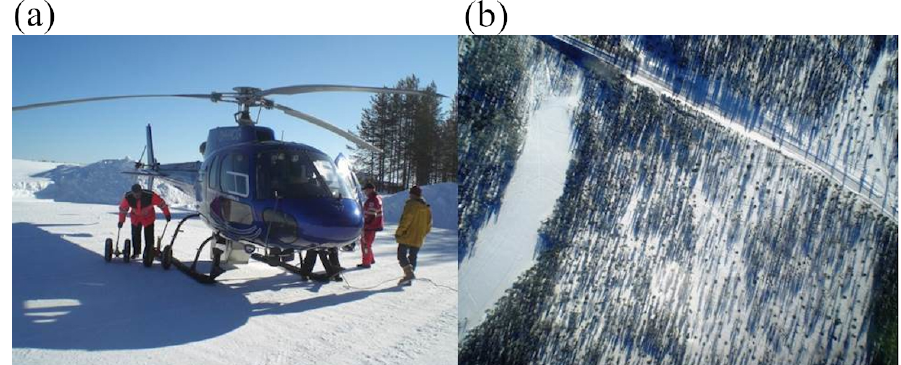
Figure 11. (a) In March 2010 the AISA acquisition was made from a helicopter. The AISA sensor was attached in a box mounted on the bottom of the helicopter. In the bottom of the box was a hole for the sensor. (b) The photo taken from the helicopter on 21 March